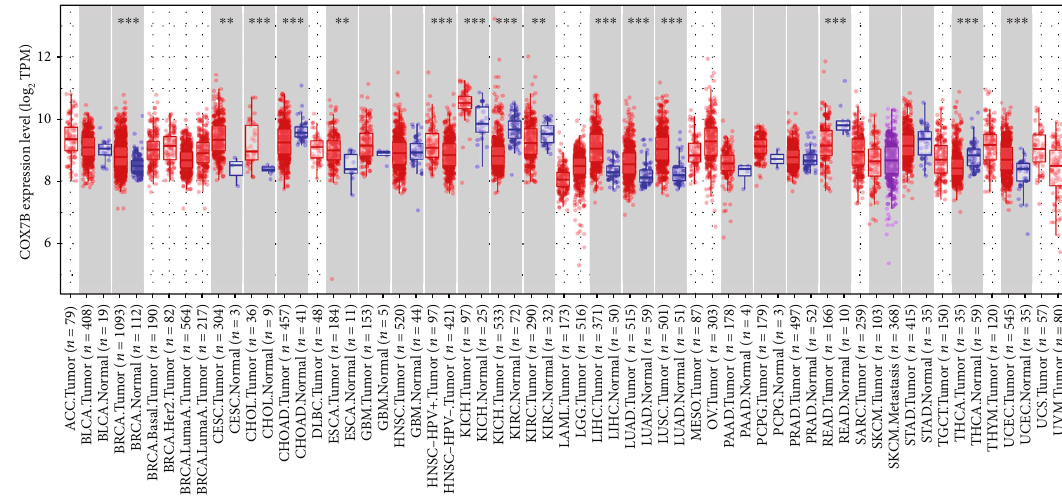
Figure 1: Pancancer analysis of COX7B